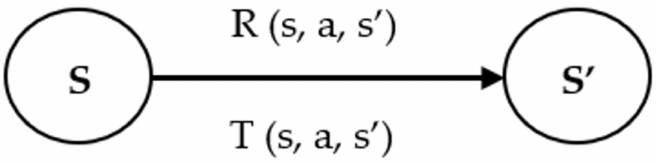
Figure 3. Reinforcement learning (Q learning algorithm) with states and